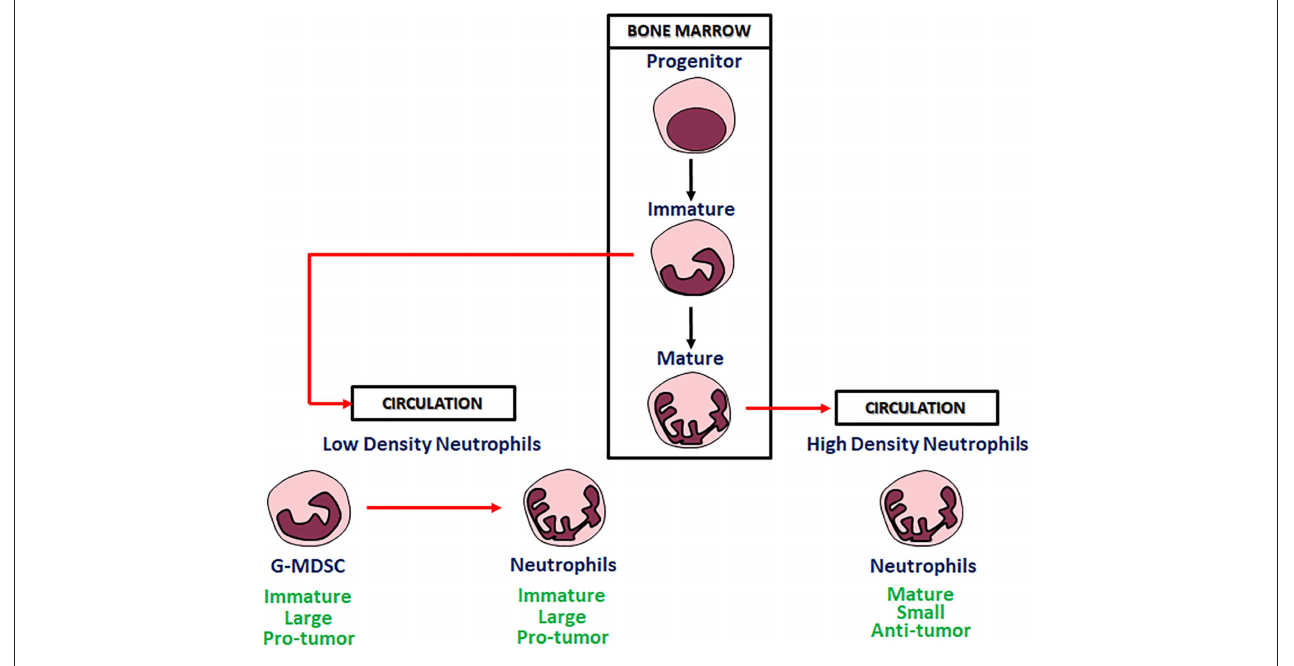
FIGURE 2 | Neutrophils in bone marrow and